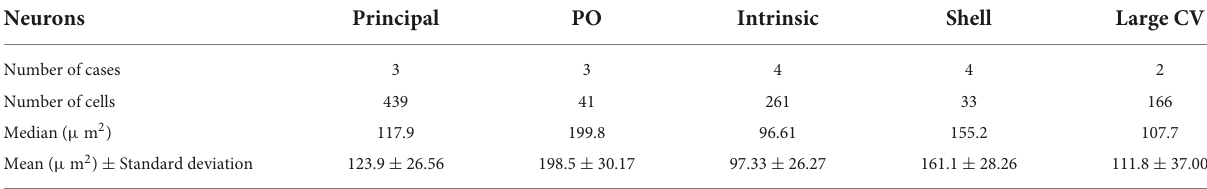
TABLE 1 Cell body silhouette area ( µ m2) for the principal and periolivary (PO) neurons and the intrinsic and shell efferent neurons.